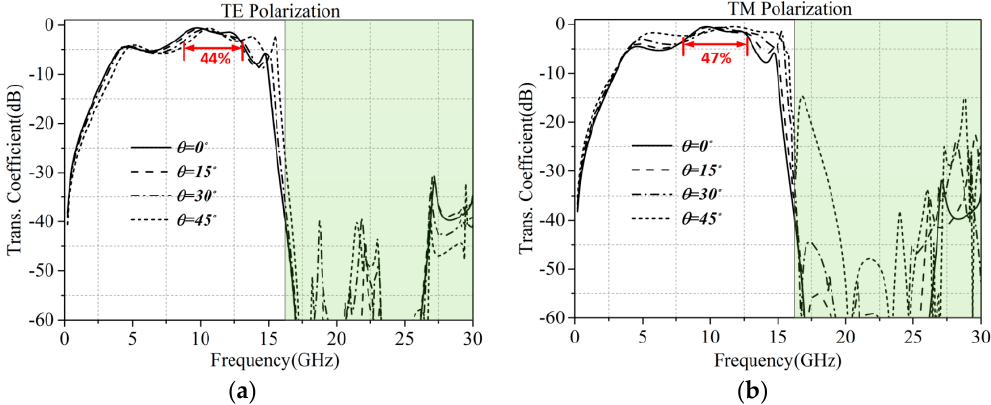
Figure 10. Transmission coefficient for oblique incidences with different angles on the multilayer patch-grid FSS with HF-FSMSE, ( a ) TE polarization and ( b ) TM polarization (The green shadow represents suppressed harmonic transmission bands).